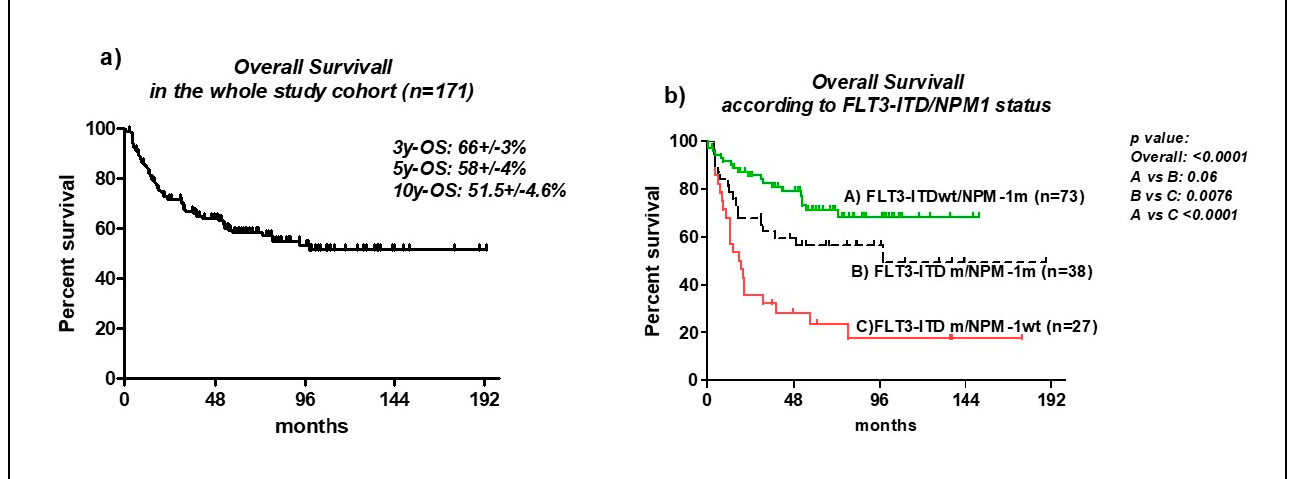
Figure 3. Overall Survival (OS): ( a ) in the whole study cohort; ( b ) According to molecular data: NPM1/FLT3 -ITD status.